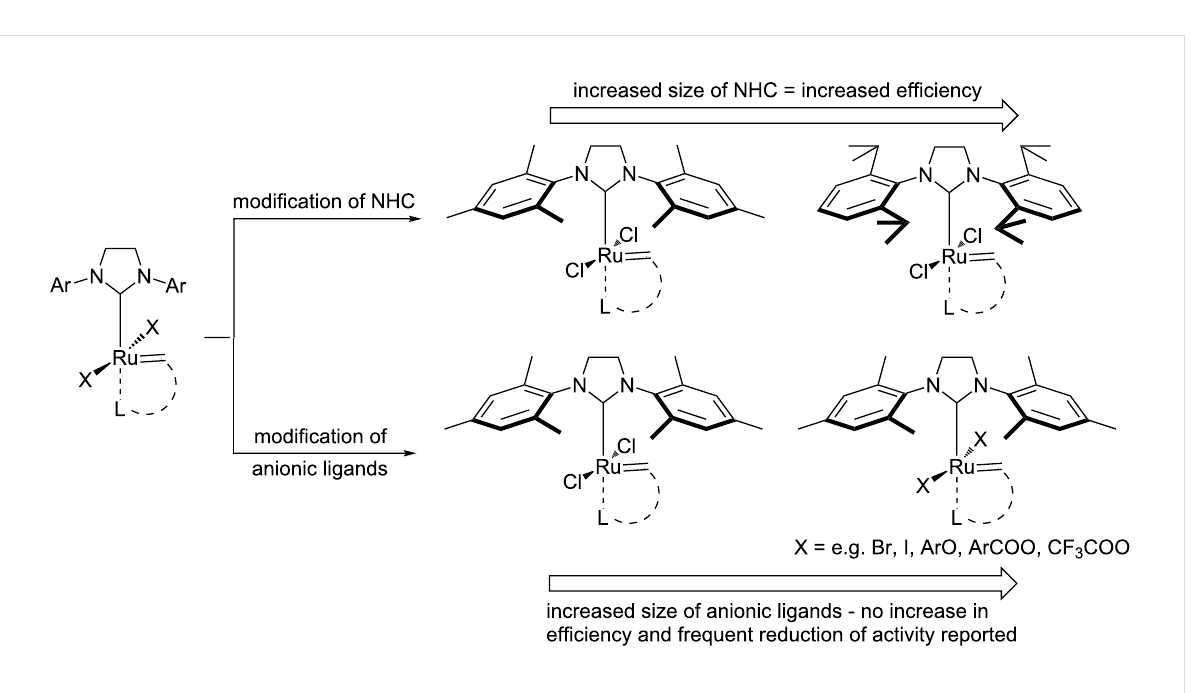
Figure 1: The diversity of Hoveyda-type complexes (Mes – 2,4,6-trimethylphenyl, DIPP – 2,6-diisopropylphenyl).